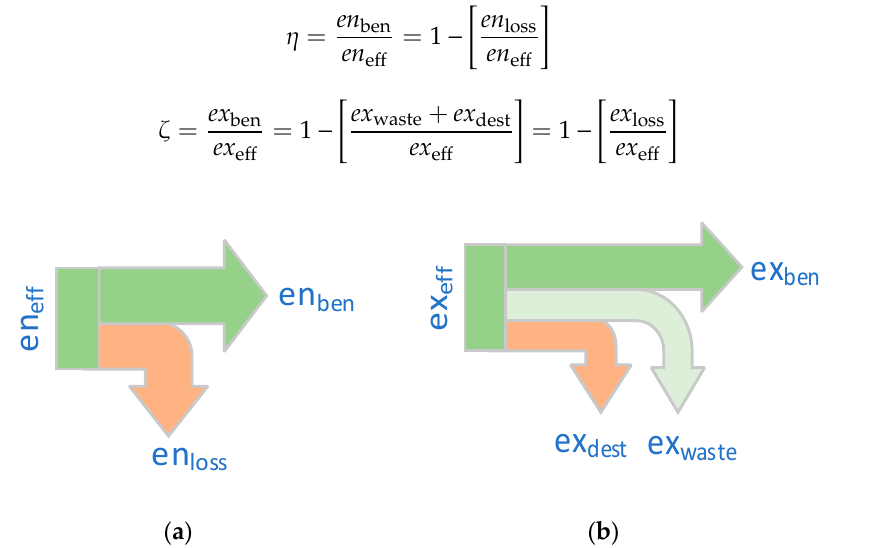
Figure 3. ( a ) Definition of energy effort (system input), usable energy benefit and unused losses (system output); ( b ) Definition of exergy effort (system input), irreversible exergy destruction, unused exergy waste and used exergy benefit (system output).